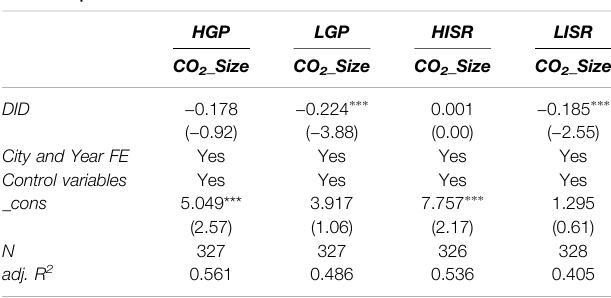
TABLE 8 | Mechanism